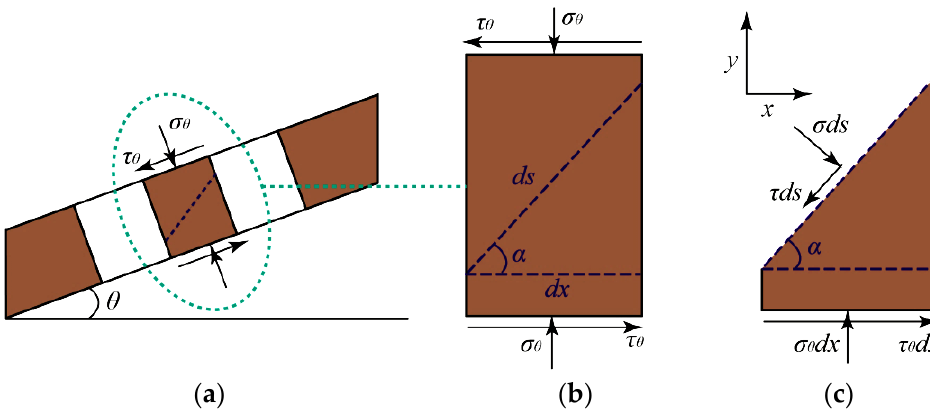
Figure 3. Sketches of inclined pillar stresses. ( a ) Loading condition of the inclined pillar; ( b ) stress state of a single pillar; ( c ) stress state of the arbitrary inclined plane.